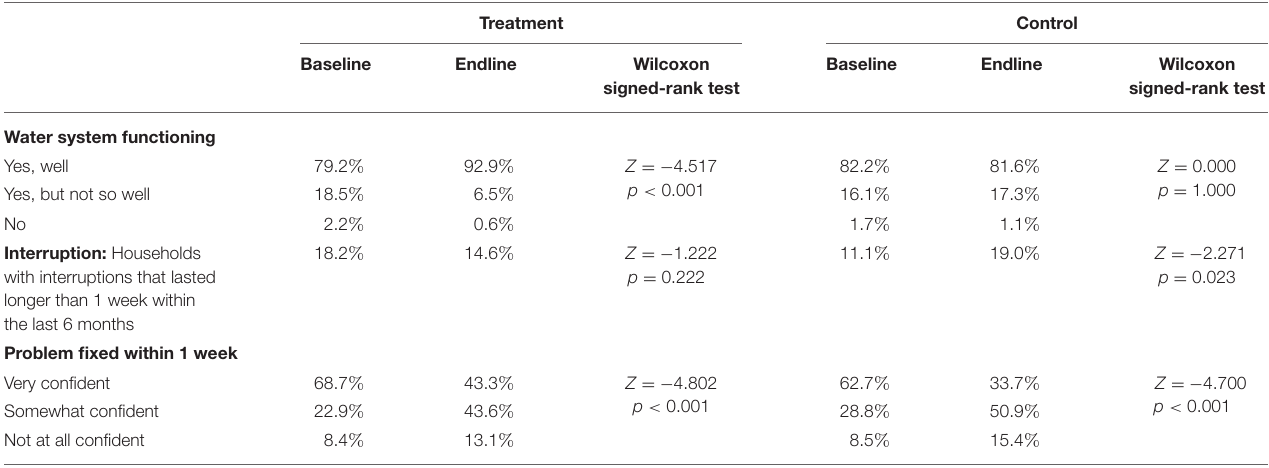
TABLE 3 | System functionality as measured by the percentage of households that reported the corresponding answer in treatment and control systems at baseline and endline, including comparison from baseline to endline with the Wilcoxon signed-rank test. Treatment